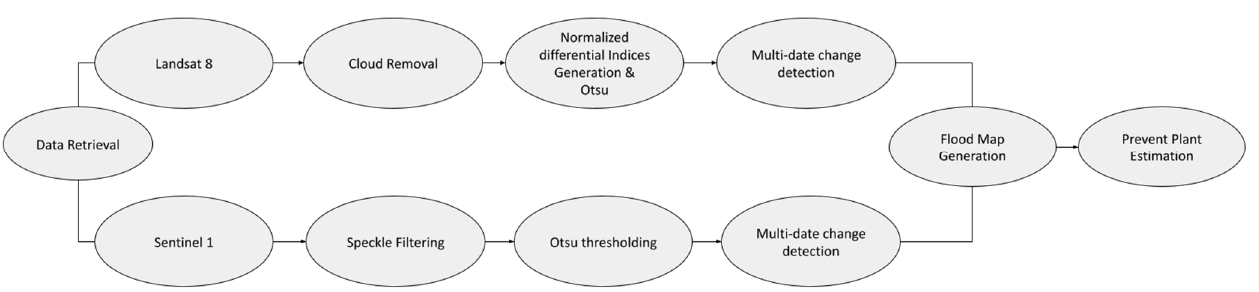
Figure 2. Processing and analysis workflow for prevent plant acres estimation.